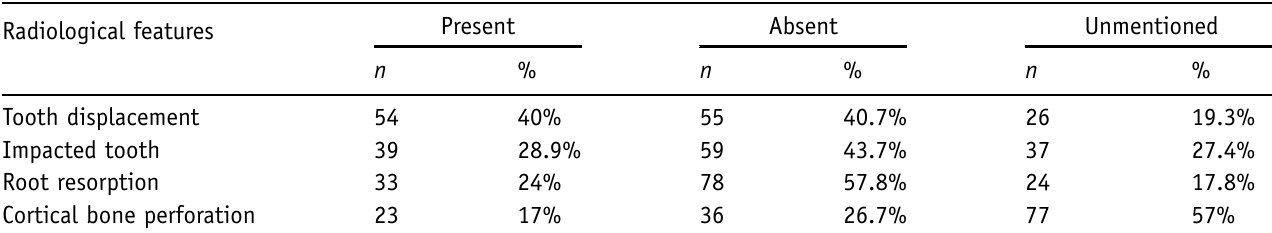
Table IV. Radiological features of the anatomical elements surrounding central odontogenic fi broma. Radiological features